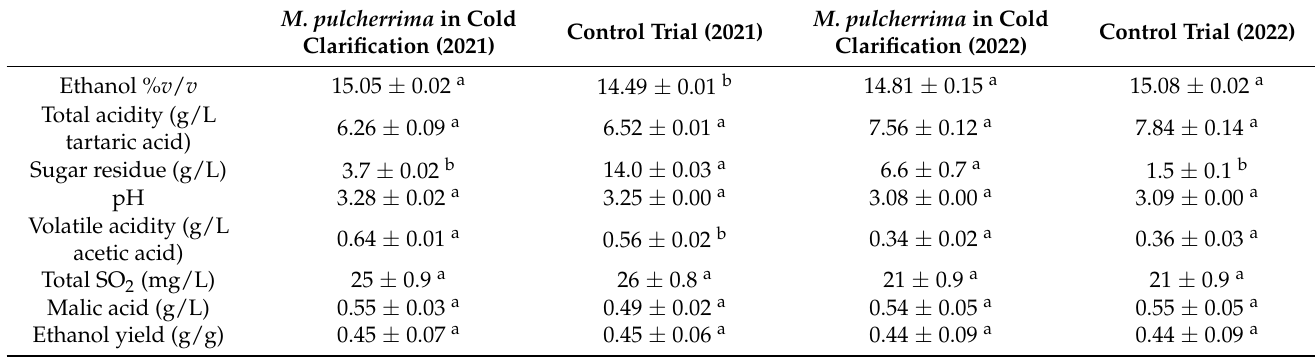
Table 2. The main analytical characteristics of resulting wine coming from 2021 and 2022 vintages.